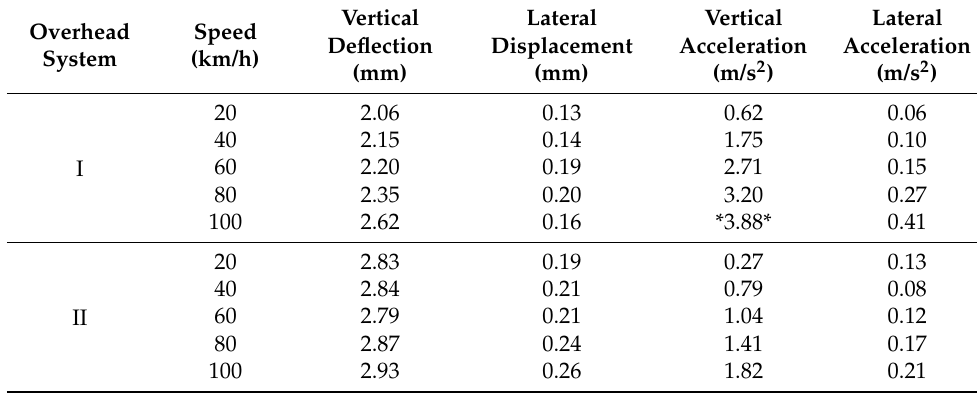
Table 11. The response of the overhead system at different